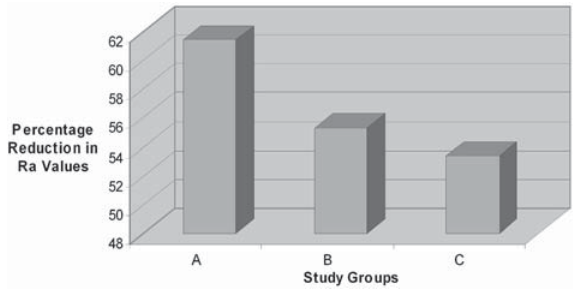
Figure 2- Percentage reduction of surface roughness (Ra) values in group A, B and C